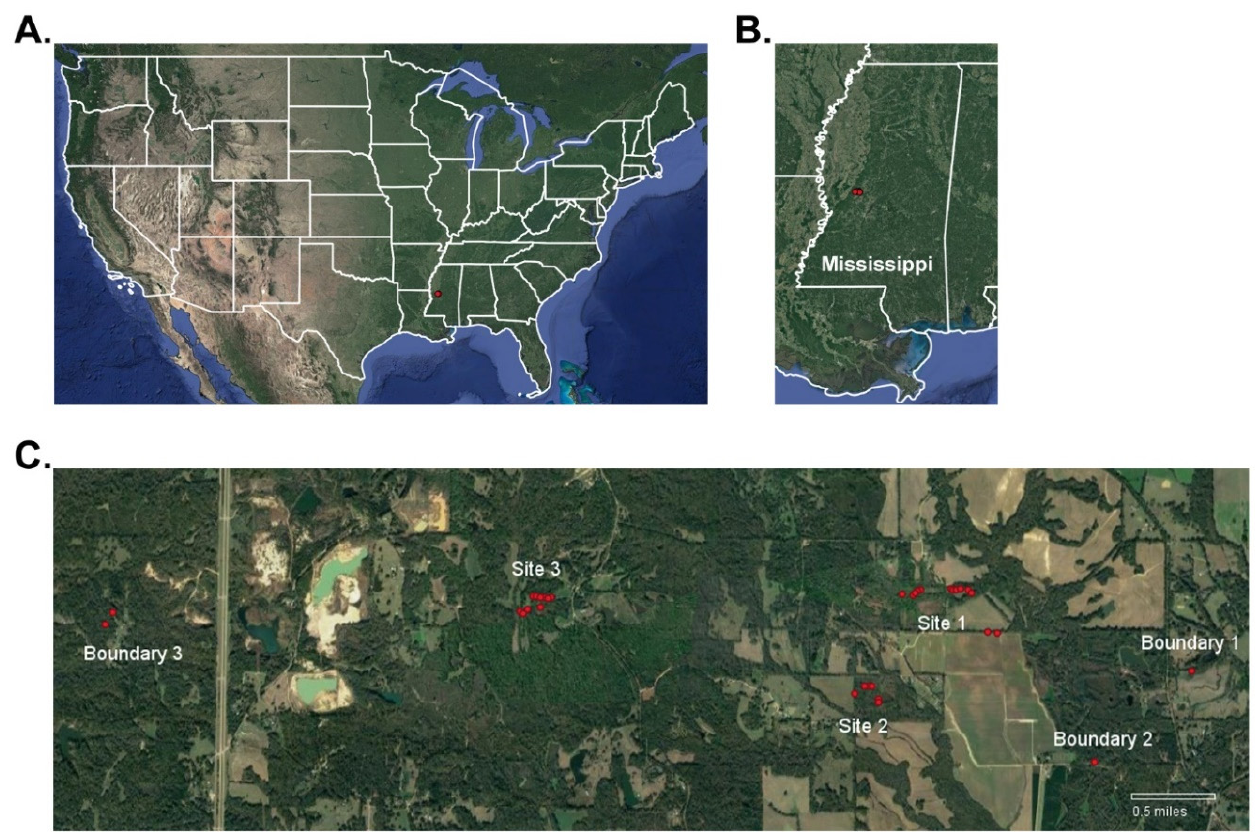
Figure 1. Study location in Bentonia, Mississippi, USA. Shown is the study location ( A ) at the national level and ( B ) at the state level marked by a red circle. ( C ) Shown is a zoomed map of the study location, which is comprised of 3 major study sites and 3 boundary sites. Scrape sites monitored by camera traps are shown as red circles throughout the study location. Scale bar: 0.5